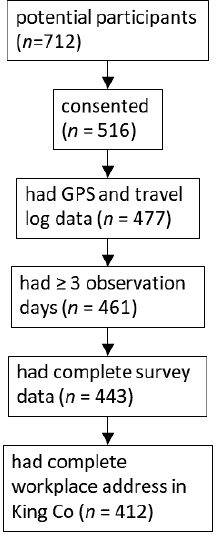
Figure 2. Subject inclusion criteria and sample size.